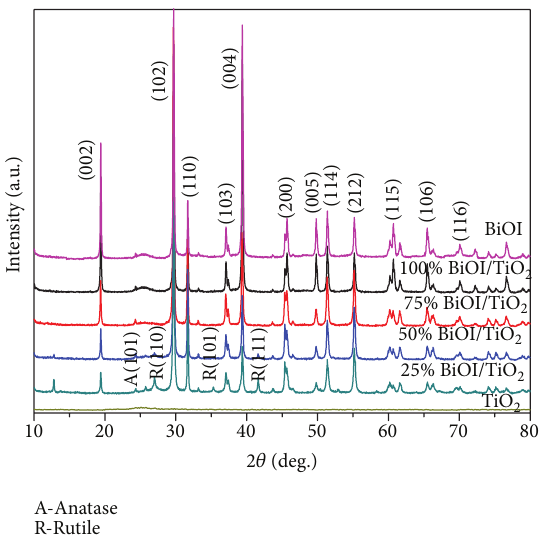
Figure 2: XRD pattern of nanoscale particles.